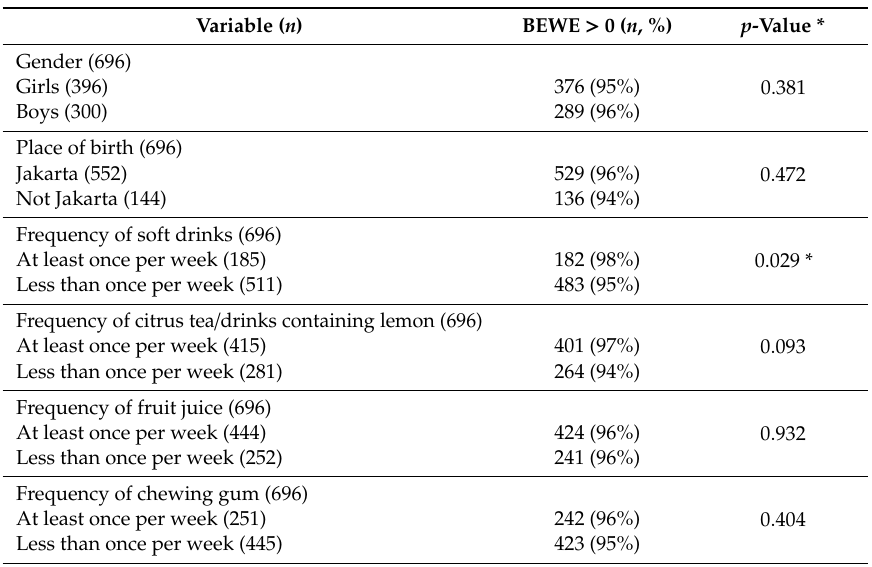
Table 5. Erosive tooth wear and studied